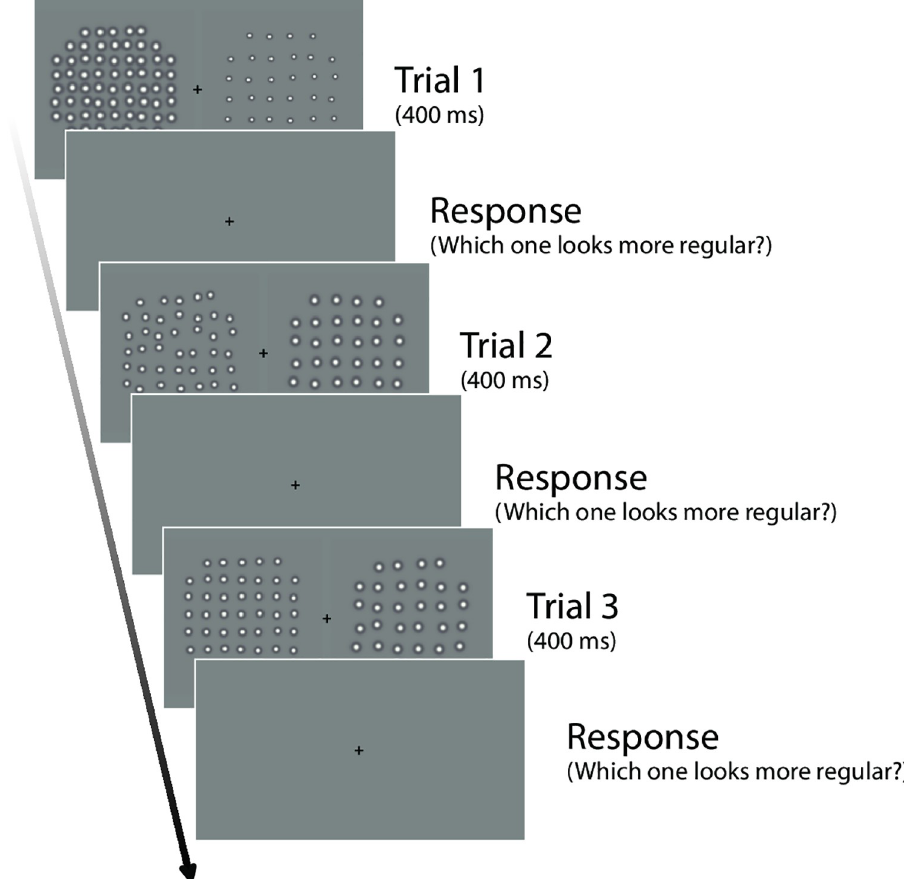
Fig 2. Stimulus presentation protocol for three example trials of the pairwise psychophysical task. A pair of element texture patterns was presented for 400 ms for each trial. Observers had unlimited time to choose the more regular-appearing pattern using a numeric keypad, followed by the next trial. A fixation target was shown throughout the experiment. Note that this schematic depiction is for demonstration purposes, and the actual size and scale of stimuli are as described in ‘Design and